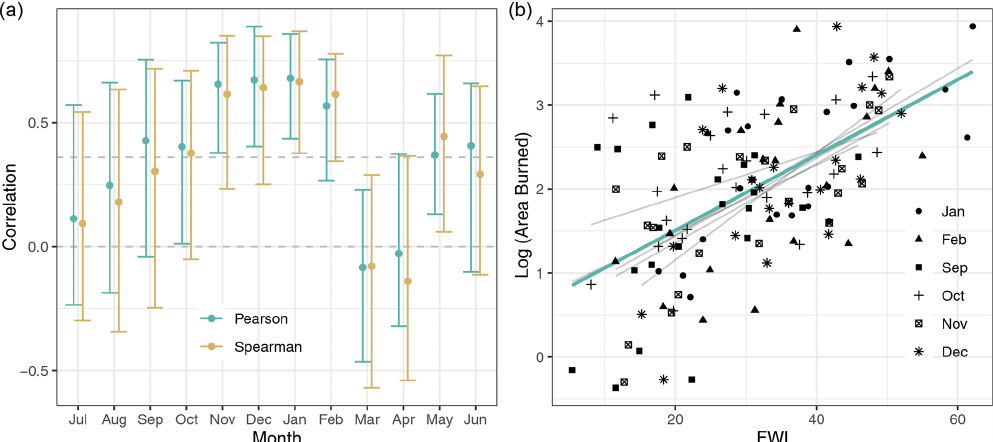
Figure 2. (a) Correlation between the logarithm of area burned ( 10 log ( km 2 ) , MODIS Collection 6) in the event domain and the 7d maximum Fire Weather Index for each month of the year. The correlations are based on the years 1997 to 2018, and the 95% two-sided confidence interval is based on bootstrapping those years. The horizontal line denotes the 5% significance critical value for a one-sided test of the null hypothesis that the correlation is zero against the alternative hypothesis that the correlation is positive. (b) Scatterplot and regression line of the values for each month of the fire season (September–February). The grey lines denote the regression lines for the individual months; the green line is for all months in the fire